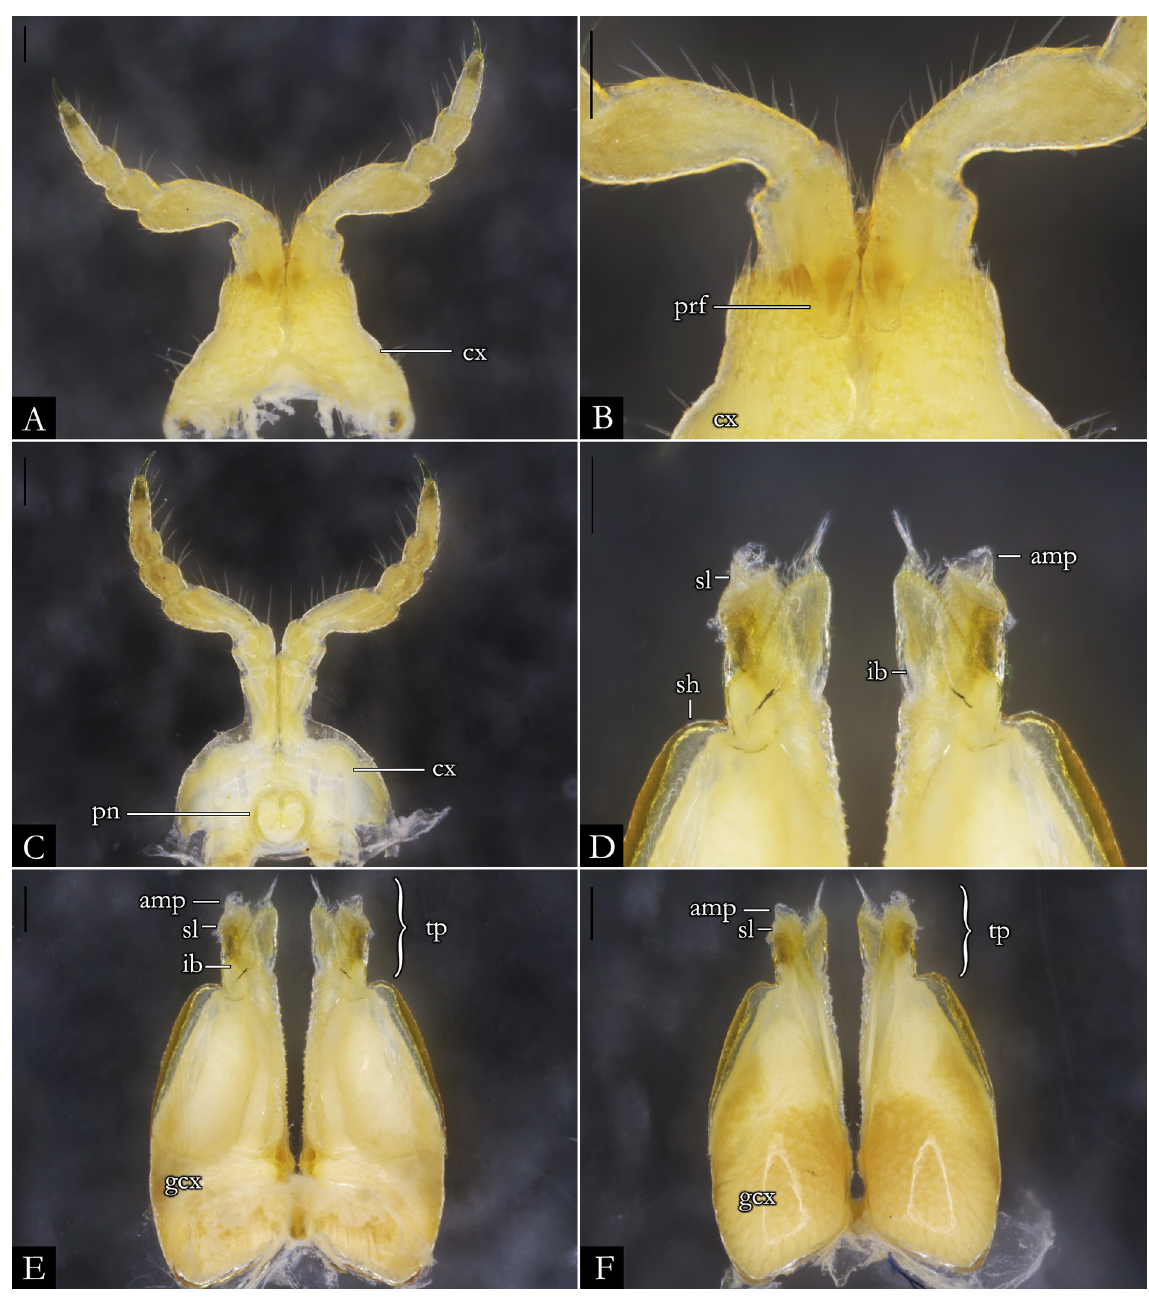
Fig. 158. Pseudonannolene morettii sp. nov., ♂ (IBSP 2476). A . First leg-pair. B . Detail of prefemur. C . Second leg-pair. D . Detail of telopodites, in anal view. E . Gonopods, in anal view. F . Gonopods, in oral view. Abbreviations: see Material and methods. Scale bars = 0.2